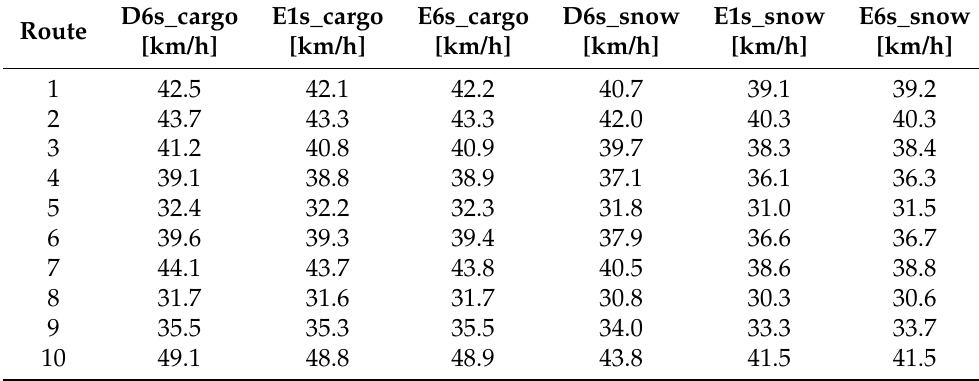
Figure 11. Simulated speeds of three vehicle types with the cargo load on routes 5, 8, and 10. Differences in the speed performance under a snow load were clearer. Figure 12 shows how the diesel truck is significantly faster than the electric versions whose accelerations are compromised not only by the additional driving resistance from snow but also by the maximum battery power limit. Moreover, the electric single-speed is moderately slower than the multi-speed on routes 5 and 8 (Figure 12). Table 5 shows that the average driving speed of the electric multi-speed truck is slightly higher compared to the single-speed version. This can be explained so that a lack of traction on ascending sections slows down the truck. On Route 10, however, the speed performance of the electric powertrains is almost equal due to the higher average speed that provides kinetic energy to overcome challenging terrain (Figure 12). Table 5. Average speeds from all simulation